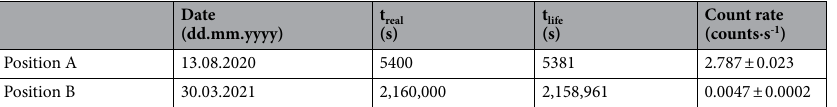
Table 2. Count rate (in counts∙s -1 ) at 58 keV corresponding to the γ-measurements of 159 Dy in Position A and Position B. The exact dates (in dd.mm.yyyy format) at which the measurements were performed are given. The real time (t real , in seconds) and life time (t life , in seconds) of each measurement are reported as